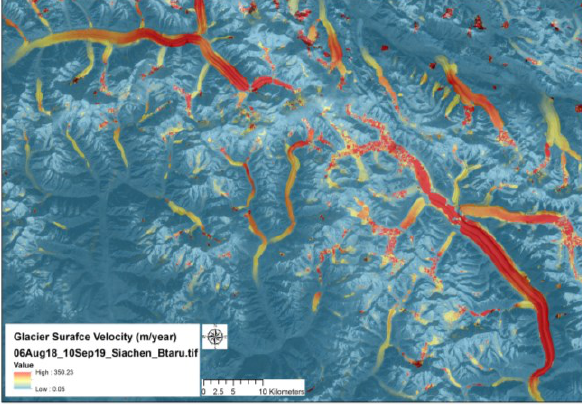
Figure 13. Glacier velocity for glaciers of Karakoram region.